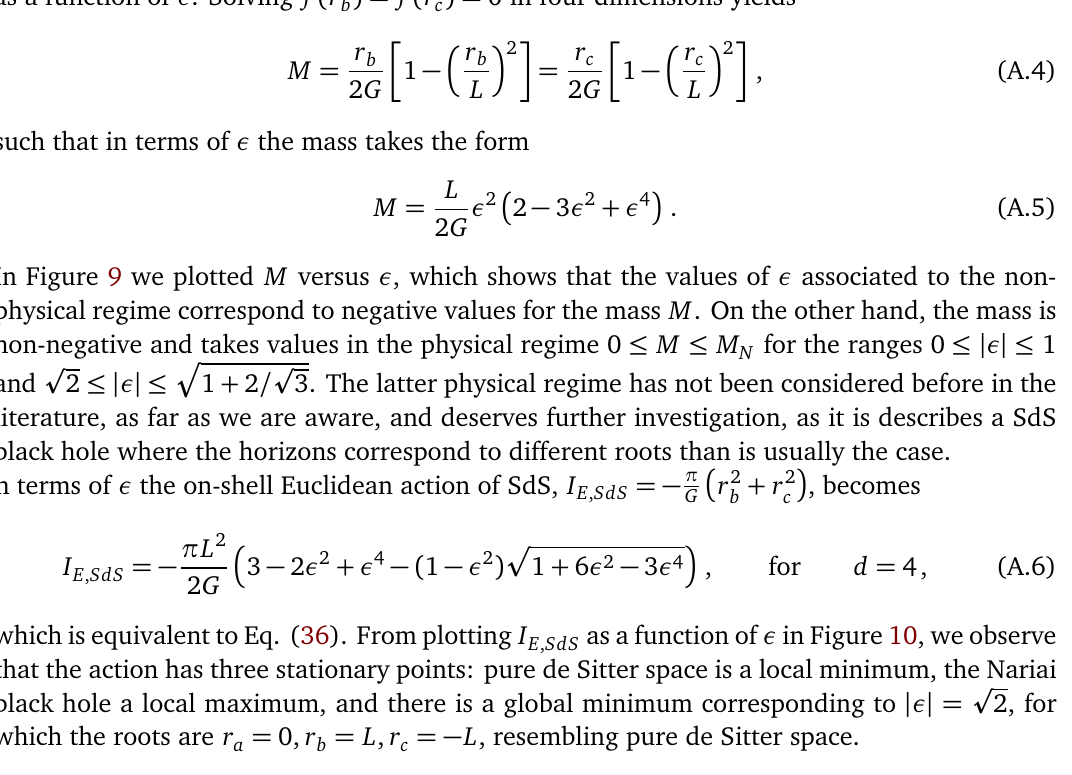
in orange and c